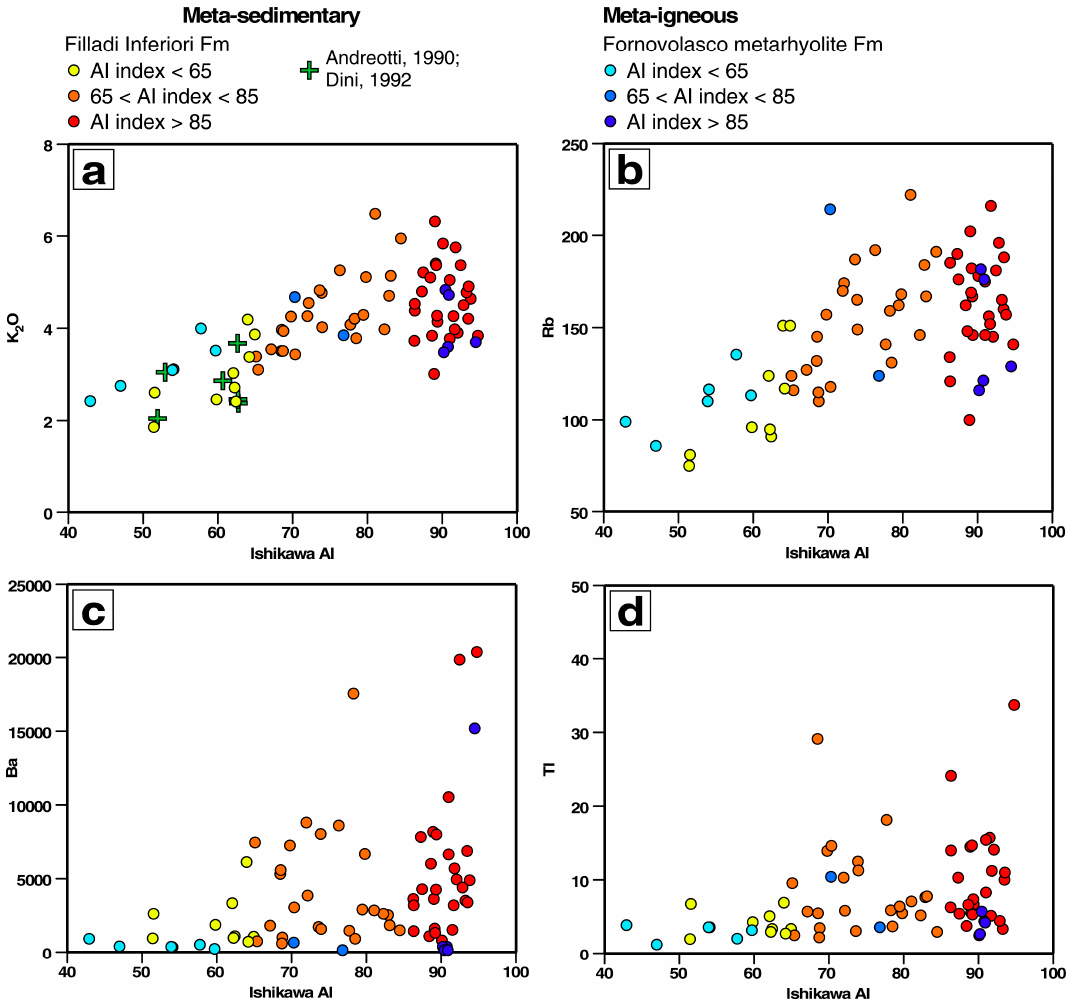
Figure 7. Plots showing correlation trends between ( a ) K 2 O, ( b ) Rb, ( c ) Ba, and ( d ) Tl vs. AI. The major and trace elements are expressed in wt% and ppm, respectively.